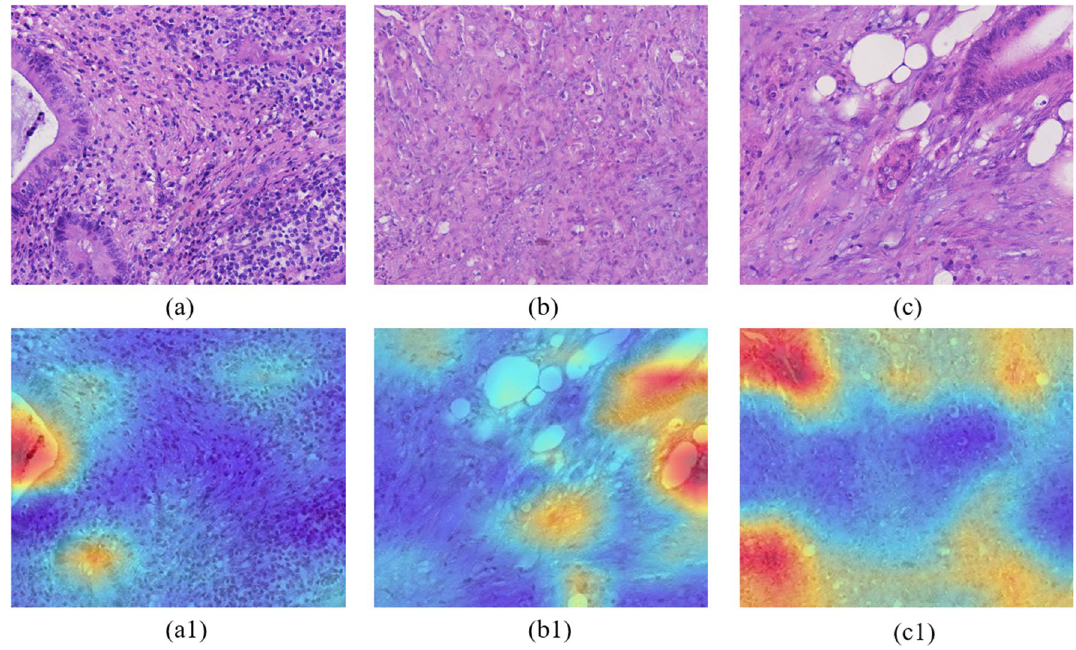
Figure 7. Histopathological images of colorectal cancer and its corresponding